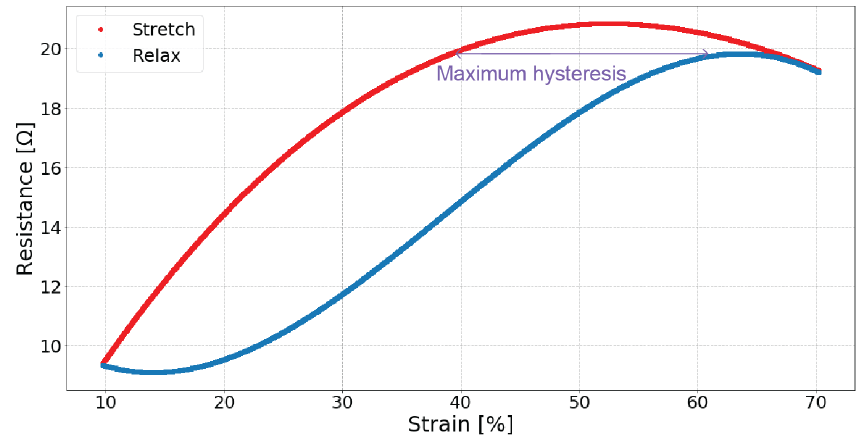
Figure 4. An example of the maximum hysteresis in the aggregated data from the dynamic test (Sample